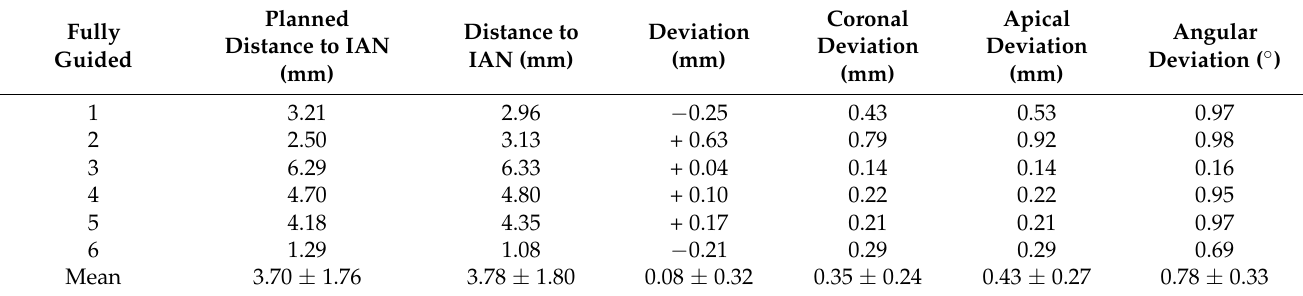
Table 3. Deviation from the planned position for fully guided surgery. Positive values of deviation indicated a surgical position further away from the IAN, negative values of deviation indicate a surgical position closer to the IAN. Fully